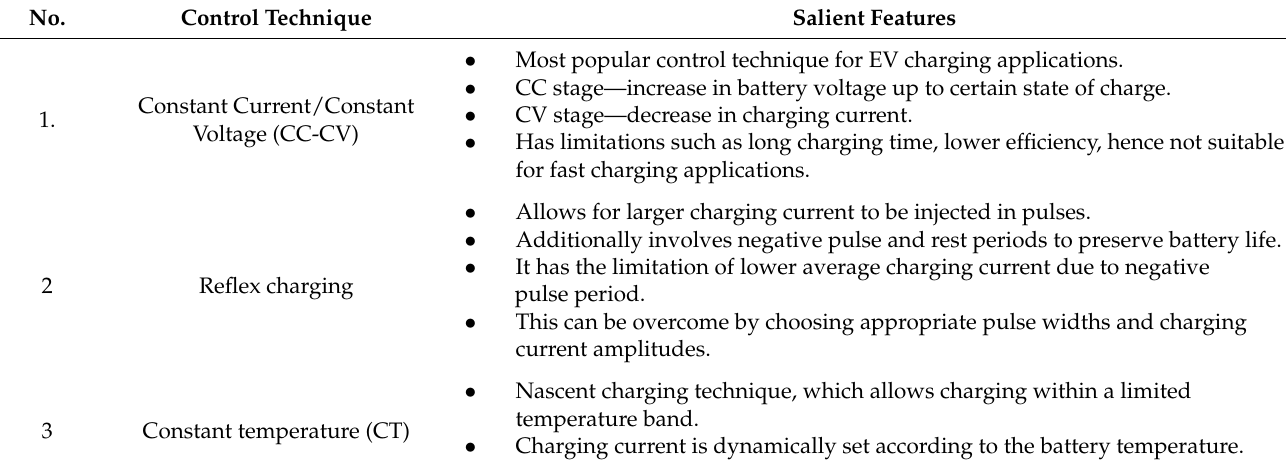
Table 5. Summary of discussed control techniques.